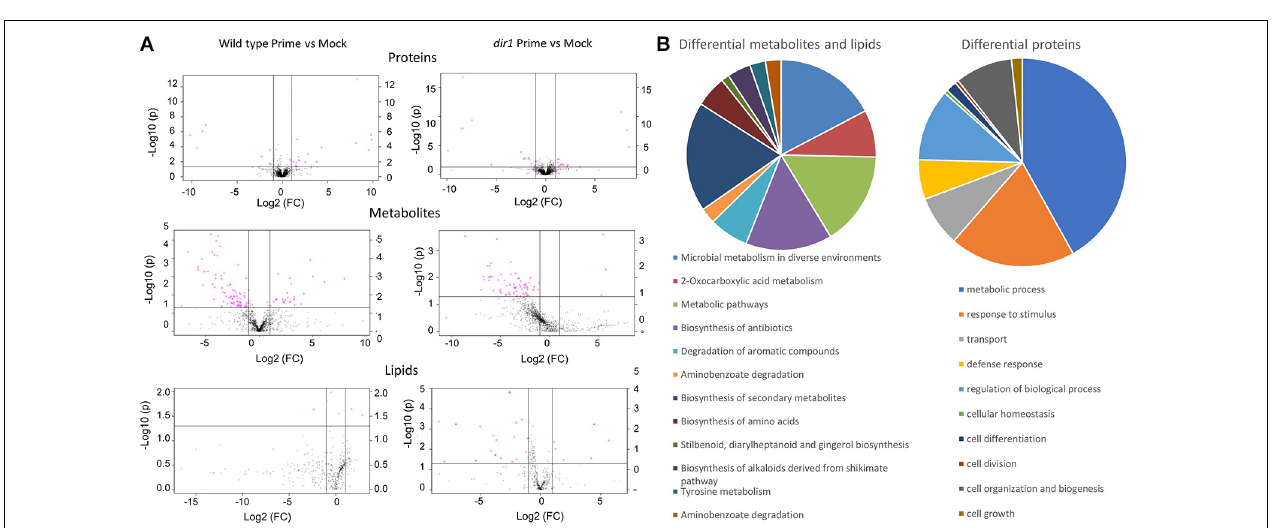
FIGURE 4 | Significant changes of proteins, metabolites, and lipids in Arabidopsis leaves of wild type and dir1 mutant primed by Pst DC 3000 treatment. (A) Volcano plots displaying differential changes of proteins, metabolites, and lipids in wild type and dir1 mutant. Pink dots indicate differential molecules. (B) Biological functions of the differential metabolites/lipids and proteins in wild type versus dir1 primed